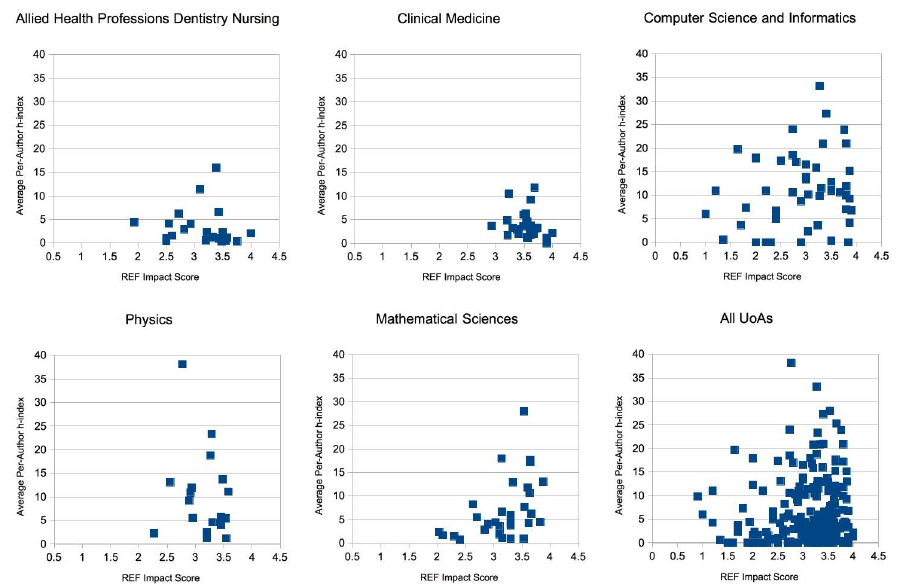
Fig 5. Average per-author h-index vs Average REF Impact